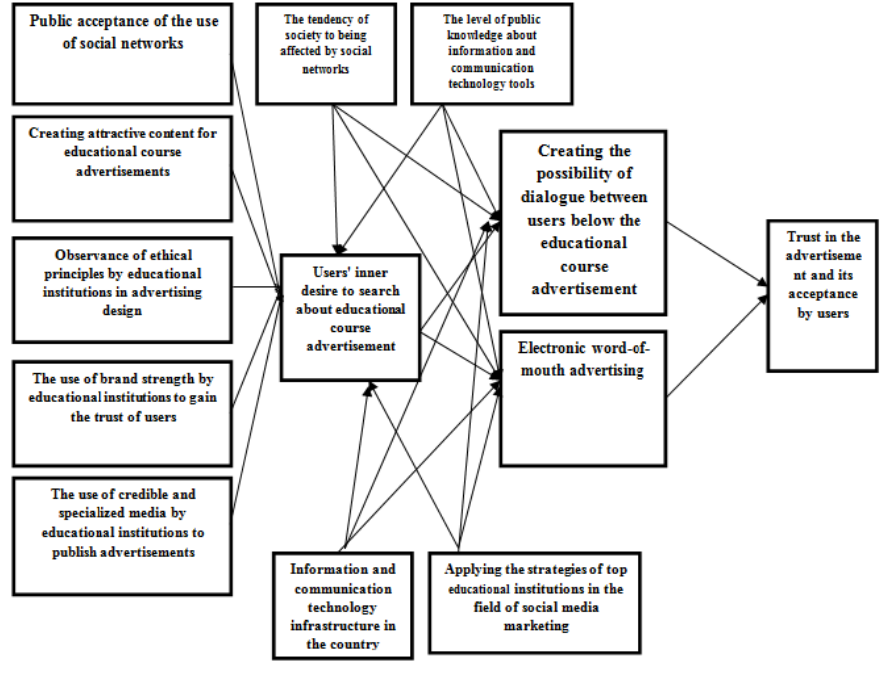
Fig. 2. Conceptual model of